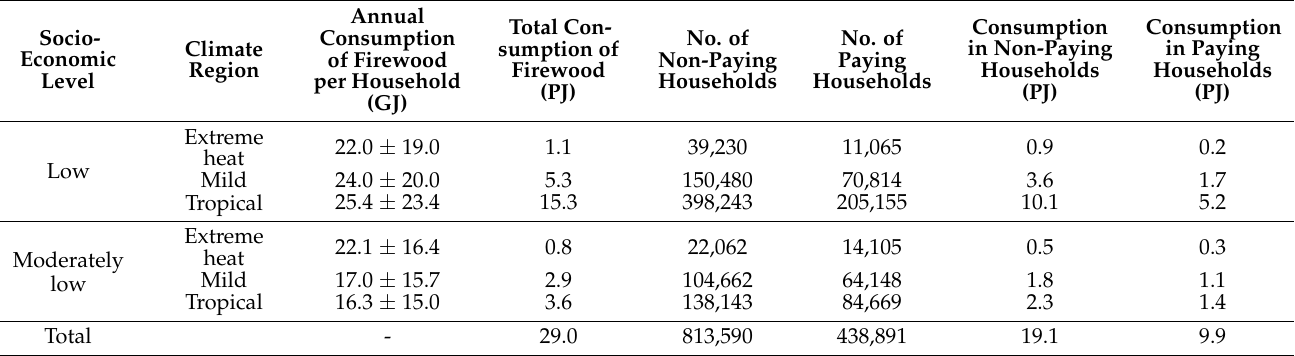
Table 3. Consumption of firewood per household, number of households, and total consumption of firewood in paying and non-paying MPU